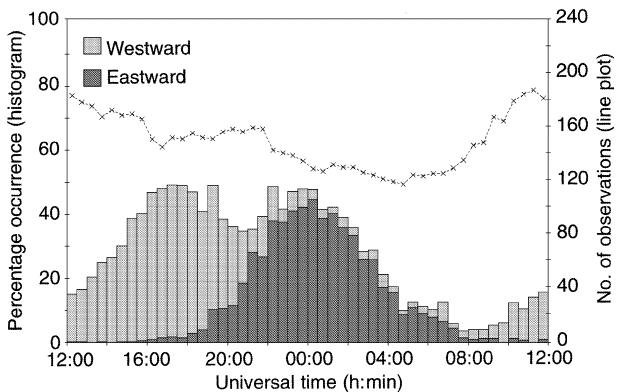
Fig. 4. Diurnal distribution of F-region ion velocities exceeding 500 m s ) 1 , observed by EISCAT. The histogram represents the percentage occurrence of enhanced ion velocity as a function of universal time, the bin width again 30 min; light grey shading indicates enhanced ion velocities with a westward zonal component, dark grey indicates those with an eastward zonal component. The line plot shows the number of observations of each